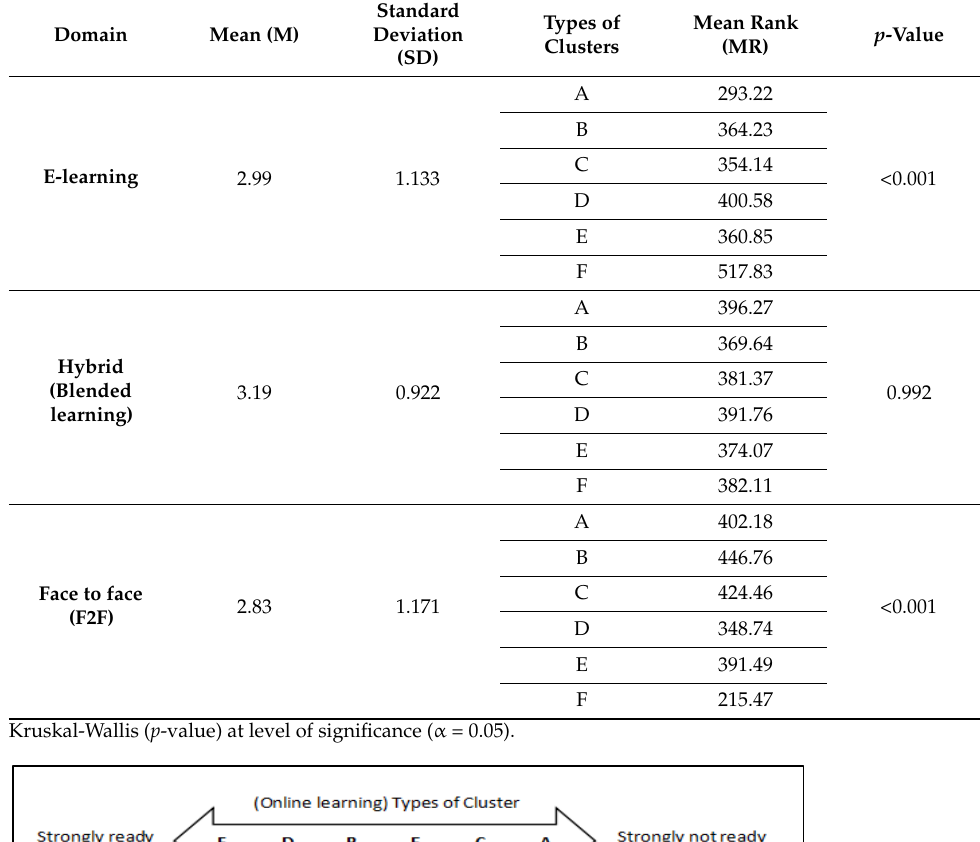
Table 5. Kruskal-Wallis test results for e-learning, hybrid, and face-to-face learning methods.